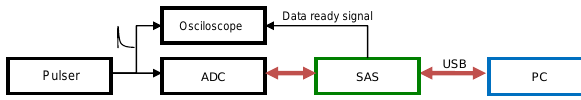
Figure 6. Block diagram used to verify the ADC conversion time. PC is only used to launch and stop SAS software.